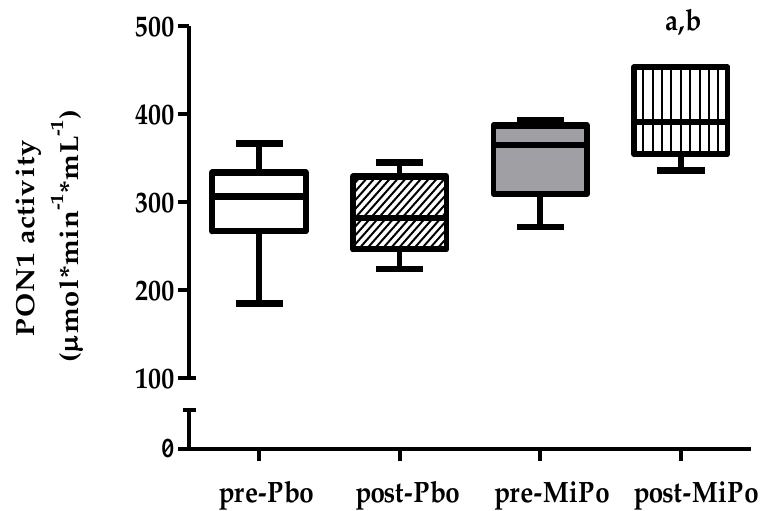
Figure 3. Effect of MiPo on paraoxonase-1 (PON1) activity. PON1 activity was determined in both MiPo and placebo groups, before (pre-) and after (post-) 30 days of supplementation with MiPo or administration with the encapsulating agent of MiPo, maltodextrin (Pbo). Data are expressed as median (horizontal lines) and interquartile range (boxes). Mann–Whitney U test. a p < 0.05, pre- vs. post-MiPo; b p < 0.05, placebo vs. MiPo after 30 days.